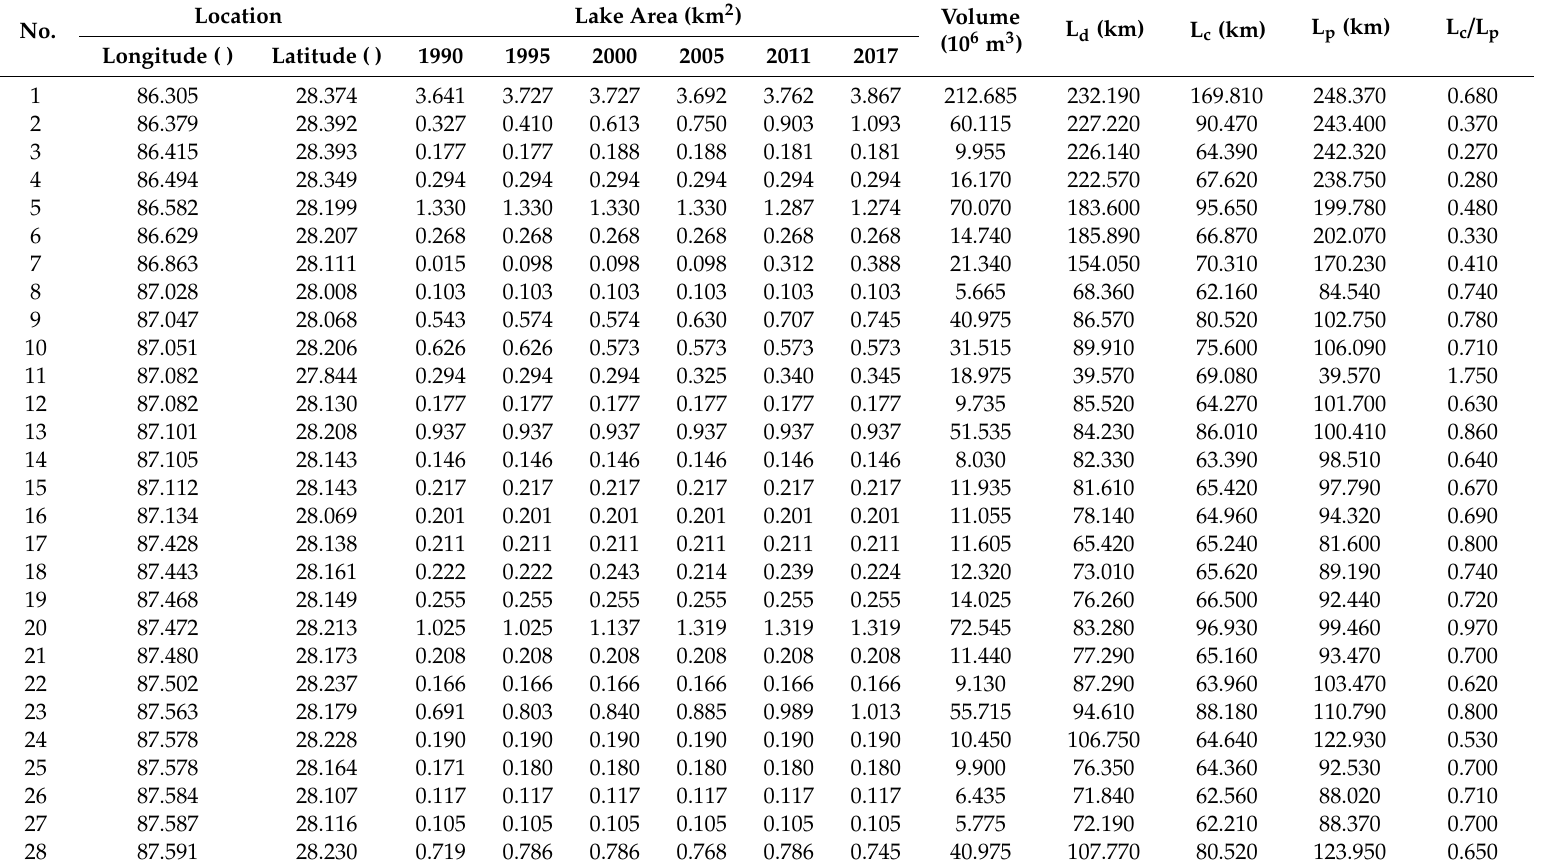
Table 2. Annual variation in area, volume, calculated a ff ected length (L c ), and distance between the lake and the dam site (L d ) and the Upper Arun powerhouse (L p ) for the 49 glacial lakes with areas > 0.1 km2 in the Arun River Basin for the period 1990–2017.